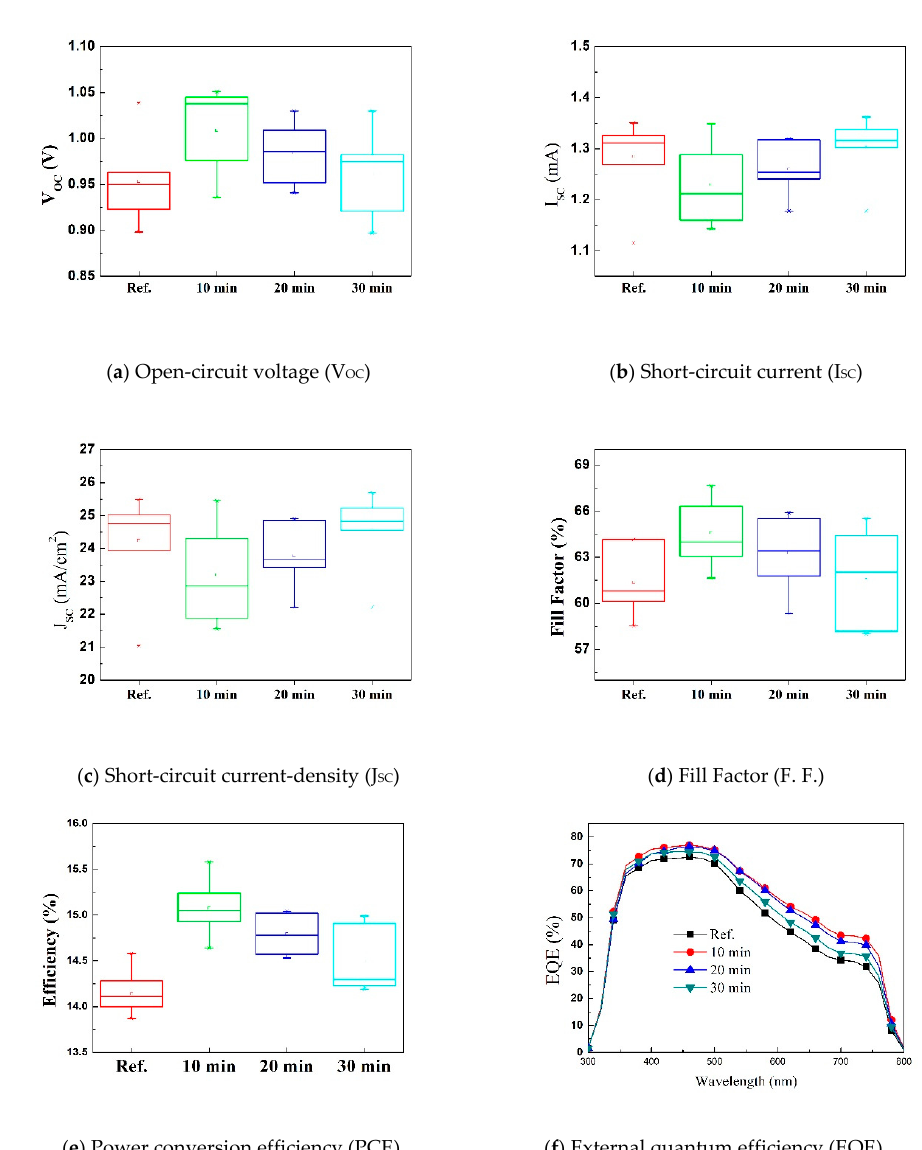
Figure 7. Photovoltaic performances of perovskite solar cells (PSCs) as a function of the UV-C light irradiation time; ( a ) open-circuit voltage, ( b ) short-circuit current, ( c ) short-circuit current-density, ( d ) fill factor, ( e ) power conversion efficiency (PCE) of prepared PSC device, and ( f ) External quantum efficiency (EQE). The box plots of ( a )–( e ) were drawn vertically indicating data distribution of photovoltaic parameters recorded from a solar simulator (AM 1.5 AM 1.5G illumination). The minimum, maximum, and average values are shown by the middle line of each box.